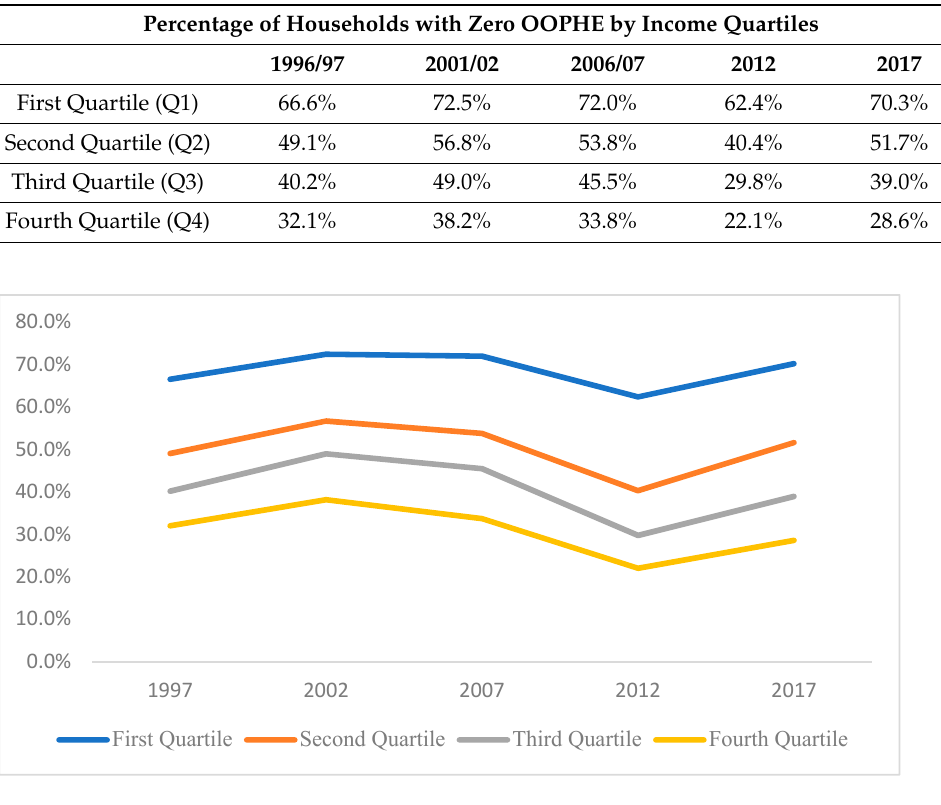
Table 2. Percentage of households with zero OOPHE by income quartiles.